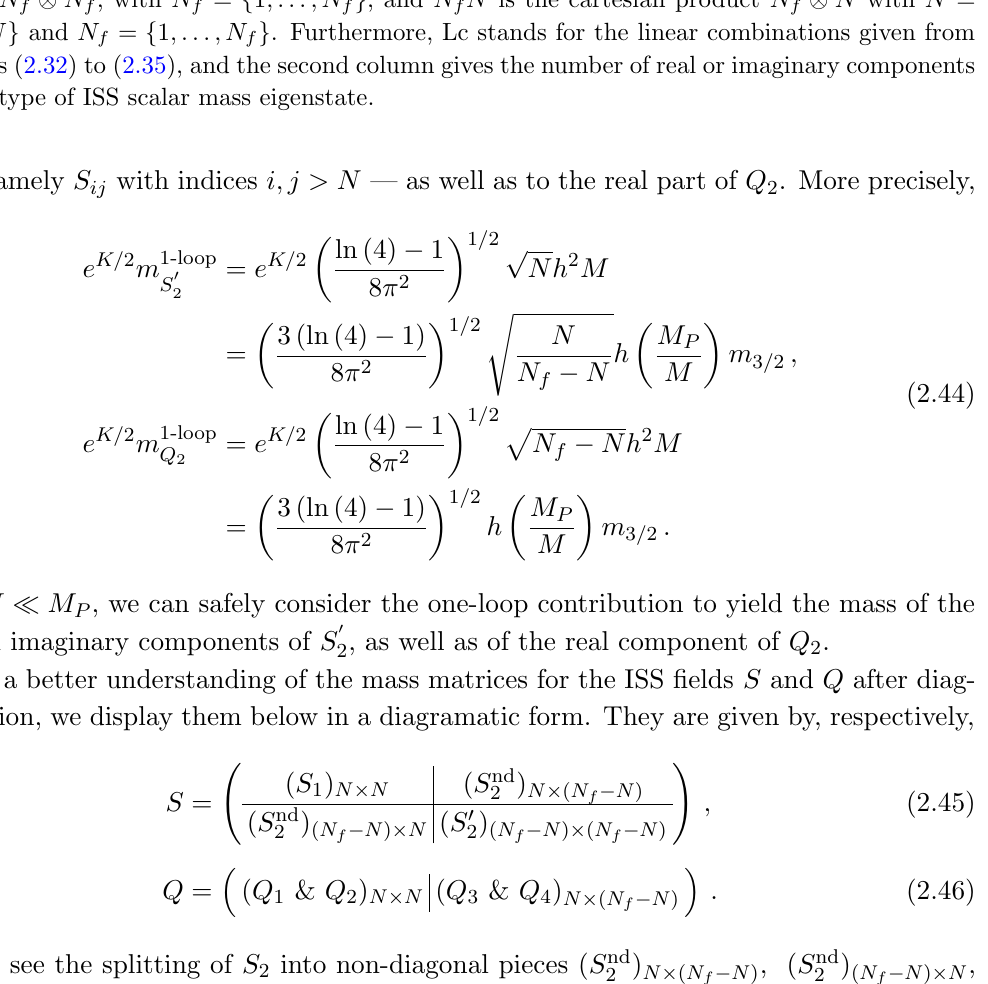
is the cartesian f